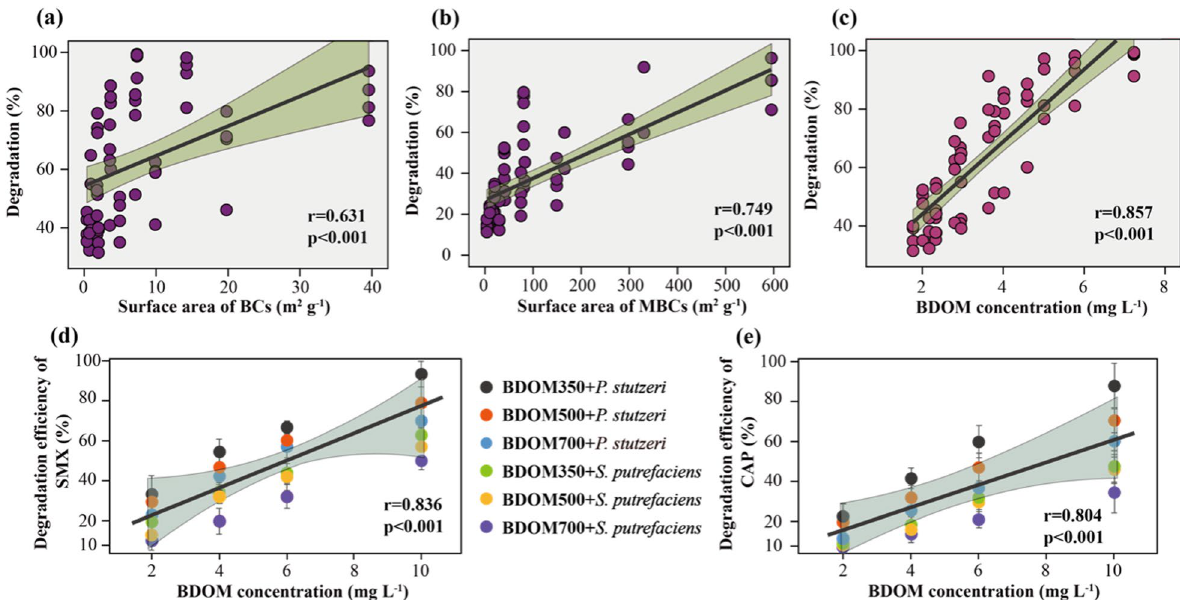
Fig. 2 The analysis between the biodegradation efficiencies of SMX and CAP by P. stutzeri and S. putrefaciens and the surface areas of BC ( a )/MBC ( b ) and the contents of BDOM ( c ) released from BC systems cultured under alternating conditions between xenon lamp irradiation and avoiding light. Figures b-c represent the biodegradation efficiencies of SMX and CAP by P. stutzeri and S. putrefaciens, respectively, which cultured with BDOM concentrations ranging from 2 to 10 mg L − 1 under visible light